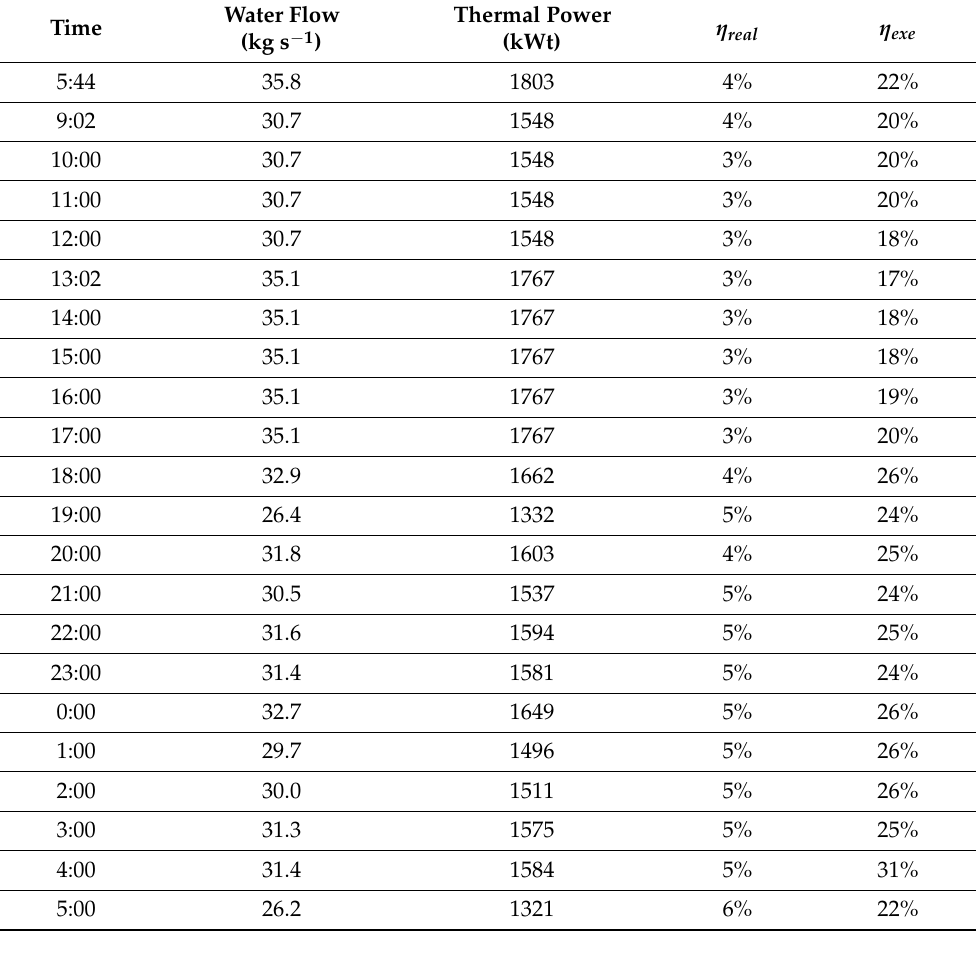
Table 3. Monitoring parameters of the energy production in the ORC system.